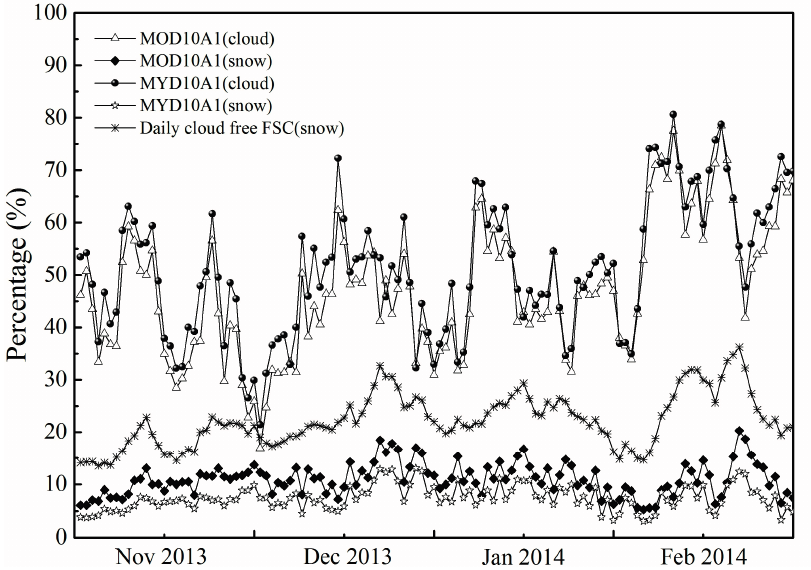
Figure 7. The curves of snow and cloud cover area retrieved from MOD10A1, MYD10A1 and produced daily cloud free FSC products during November 2013 to February 2014 in